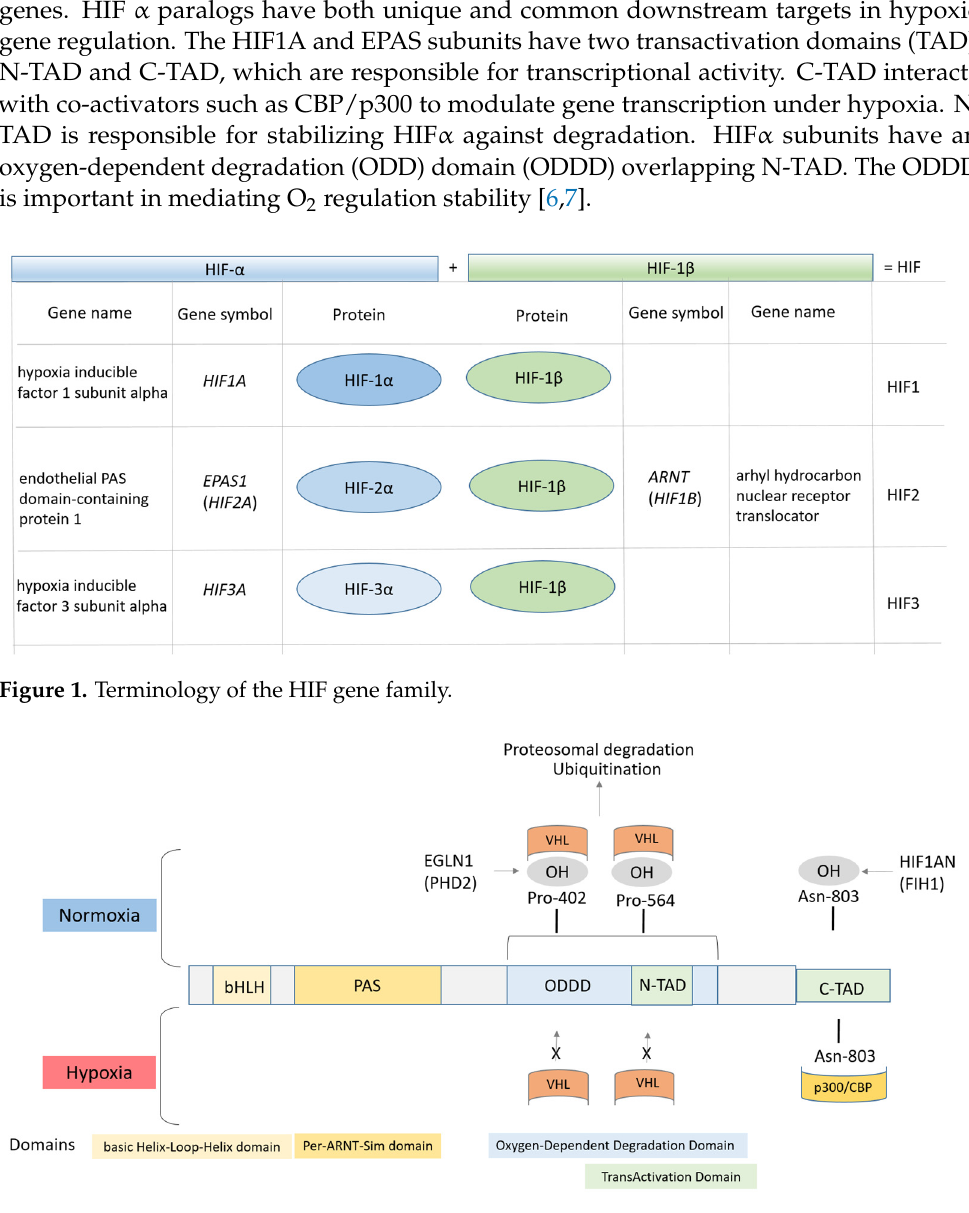
Figure 2. Structure of the HIF1 α protein. bHLH: basic helix–loop–helix; PAS: Per-ARNT-Sim domain; ODDD: oxygen-dependent degradation domain; TAD: transactivation domain.